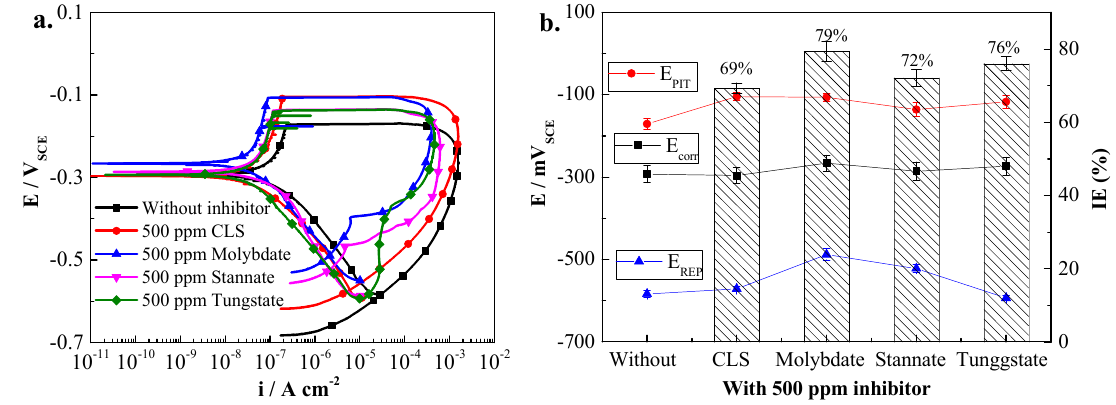
Figure 2. Cyclic potentiodynamic polarization (CPP) curves of Q235 carbon steel in test solution with different inhibitors ( a ) and electrochemical parameters of CPP curves ( b ). CLS, calcium lignosulfonate; IE, inhibition efficiency.